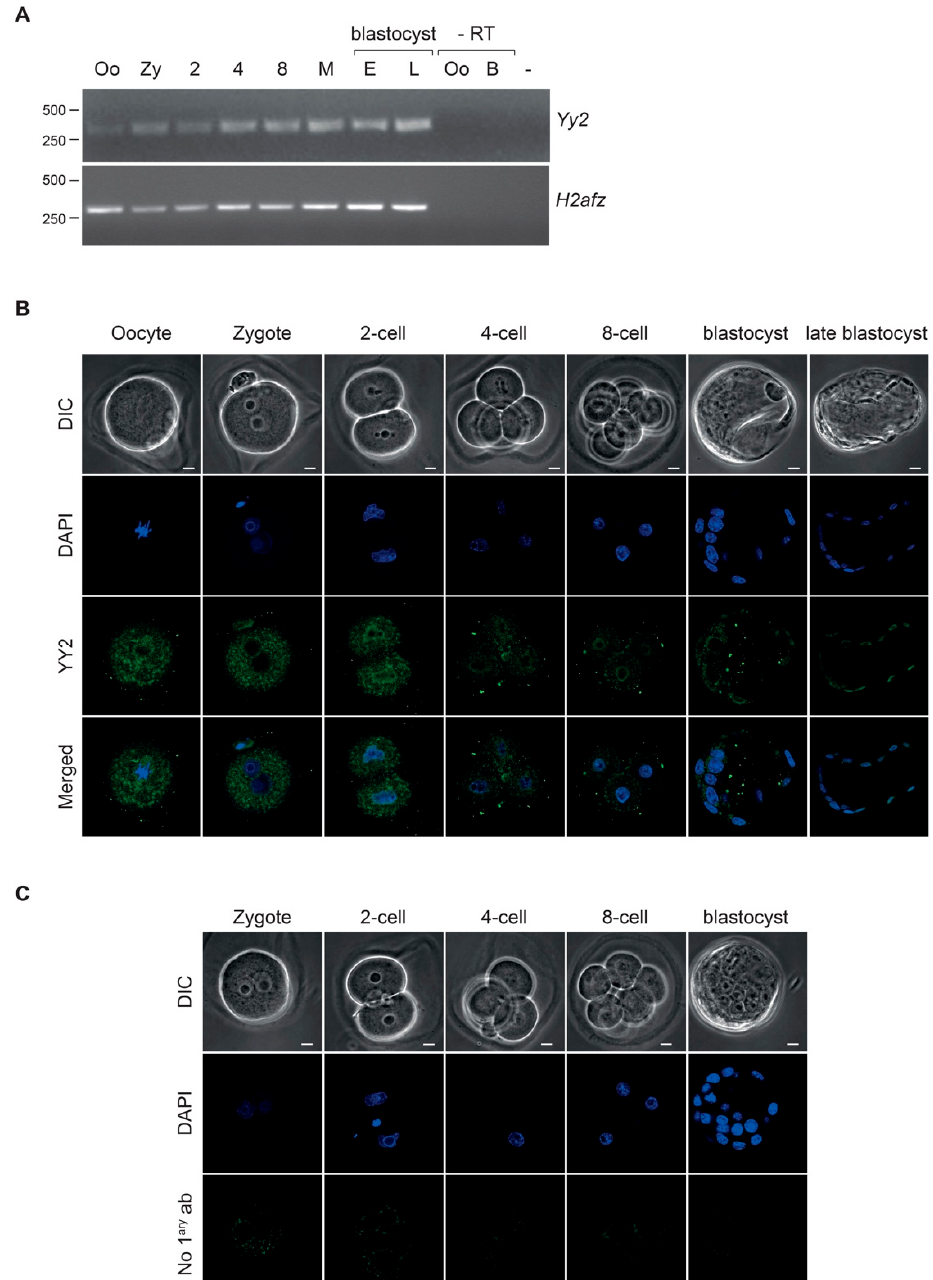
Figure 1. YY2 is present throughout mouse preimplantation development. ( A ) Detection of mRNA encoding Yy2 in mouse oocytes and preimplantation embryos by RT-PCR. RNA extracted from ~ 25 pooled oocytes or embryos at each stage was reverse-transcribed and subjected to PCR using primers to amplify either Yy2 or H2afz gene as a control. O, oocyte at metaphase II, Zy, zygote; 2, 2-cell; 4, 4-cell; 8, 8-cell embryos; M, morula, E, early blastocyst, L, late blastocyst (E4.5). RT refers to controls without reverse transcription; a PCR reaction without input ( - ) is shown to the right. The sizes of molecular weight markers run alongside are indicated on the left. ( B ) Indirect immunofluorescent detection of YY2 in confocal sections of representative mouse embryos depicted as DIC images. DAPI staining indicates chromatin (blue). The antibody used has been shown to specifically detect YY2 in immunofluorescence (Figure 1A and Figure S4 in [24]). Scale bar, 10 µ m. ( C ) Absence of unspecific background in indirect immunofluorescence. Confocal sections of preimplantation mouse embryos incubated without primary antibody (control), processed in parallel to the indirect immunofluorescent detection of YY2 shown in Figure 1B. Scale bar, 10 µ m.